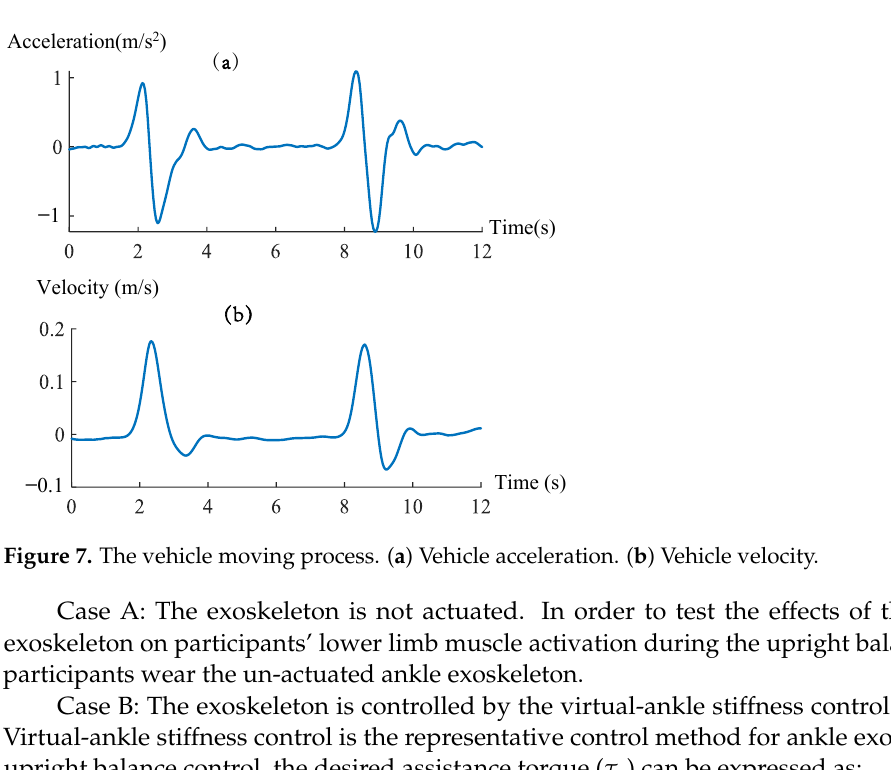
participants wear the un-actuated ankle exoskeleton.